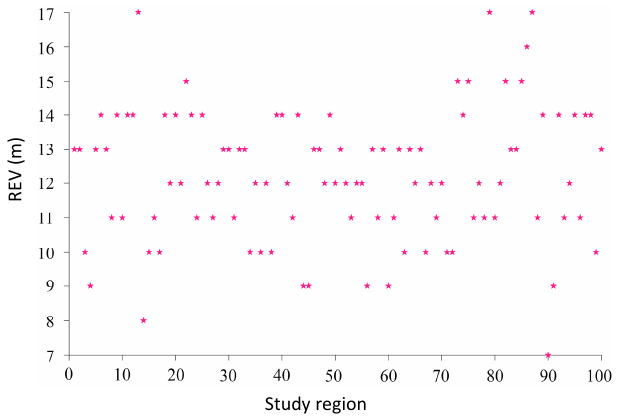
Figure 9. The REV values varied with the study regions.